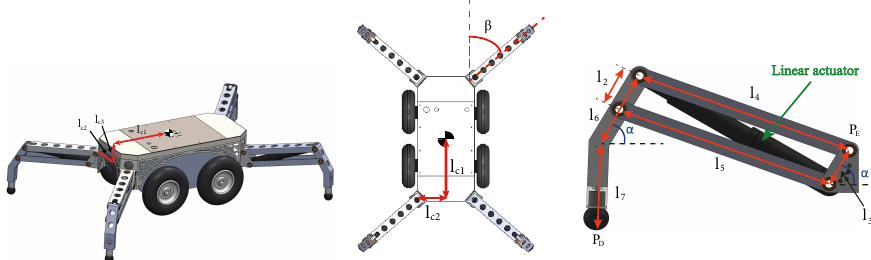
Figure 1. ( a ) front view of the mobile platform; ( b ) top view of the mobile platform; ( c ) scheme of a leg of the